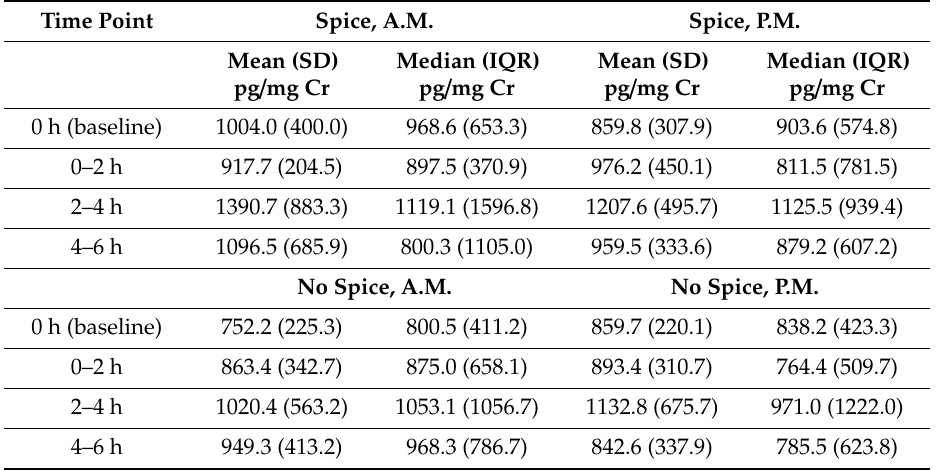
Table 4. Urine 8-isoprostane concentrations by treatment, clock time and time point.